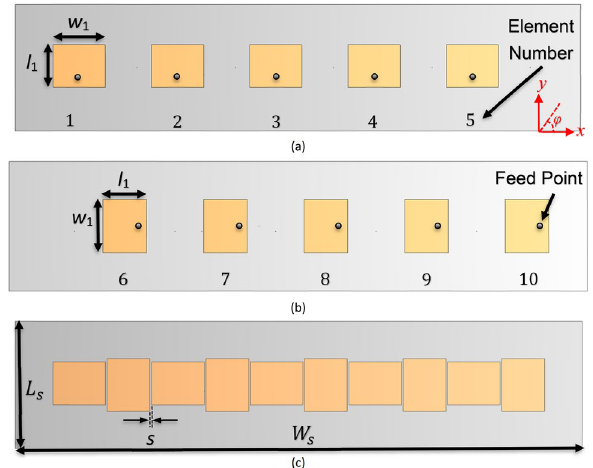
Figure 1. Configurations of the two patch arrays. ( a ) array I in H-plane arrangement, ( b ) array II in E-plane arrangement, ( c ) two tightly spaced interleaved uncloaked arrays.